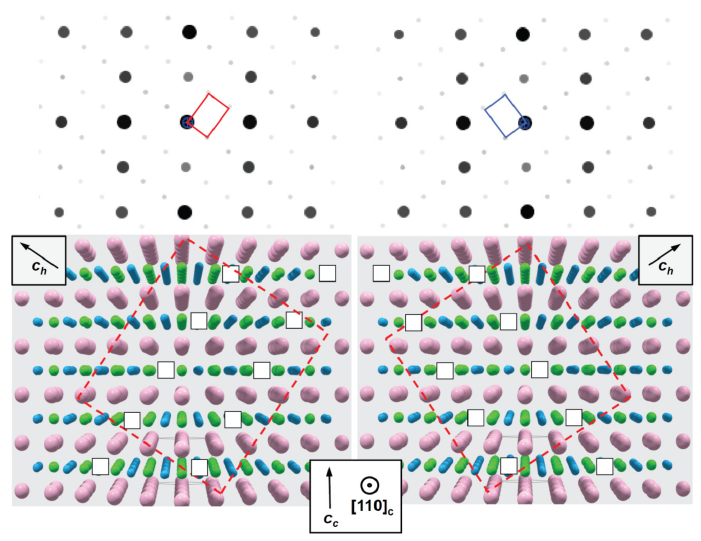
Figure 6. Structure model of oxygen vacancy ordering in planes parallel ( 111) ( left ) and (1 11) ( right ), respectively; projection along [110] (directions according to cubic setting, subscript c ; except the additionally indicated [001] direction with respect to the hexagonal setting, subscript h ). The indication of atoms is as follows: blue, oxygen; pink, barium; green,